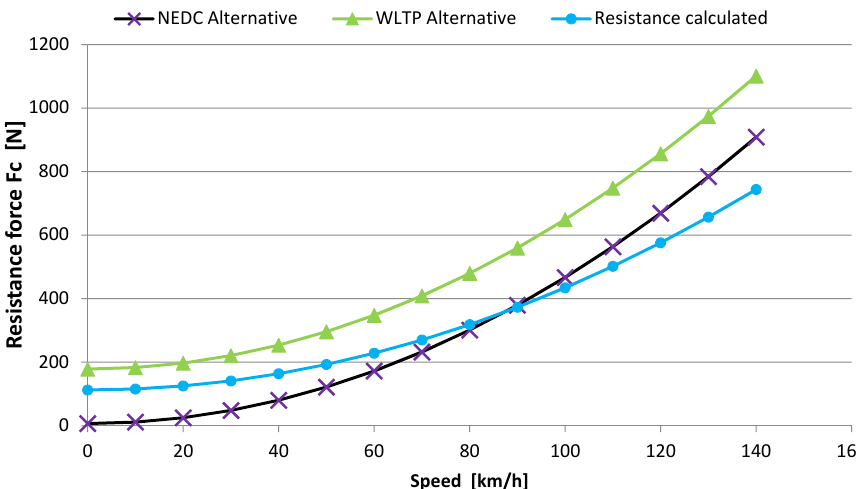
Figure 2. Dependence of resistance force on vehicle speed for the analysed methods.